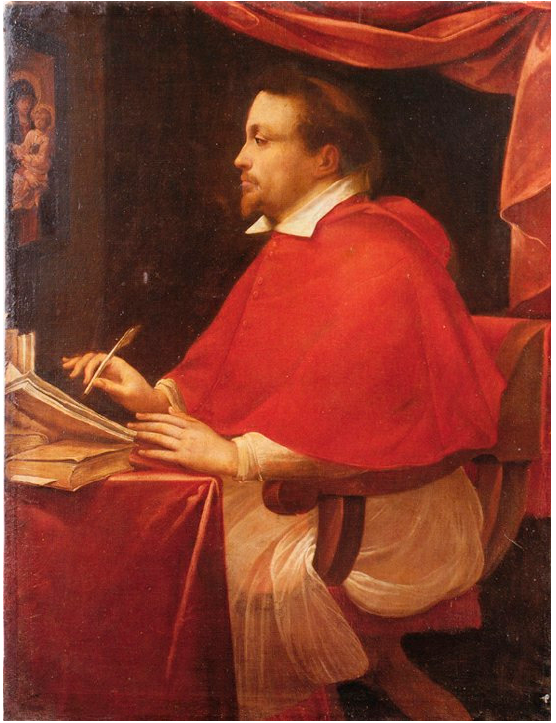
Figure 3. Giulio Cesare Procaccini, Cardinal Federico Borromeo , Milan, Museo Diocesano (image in the public domain).